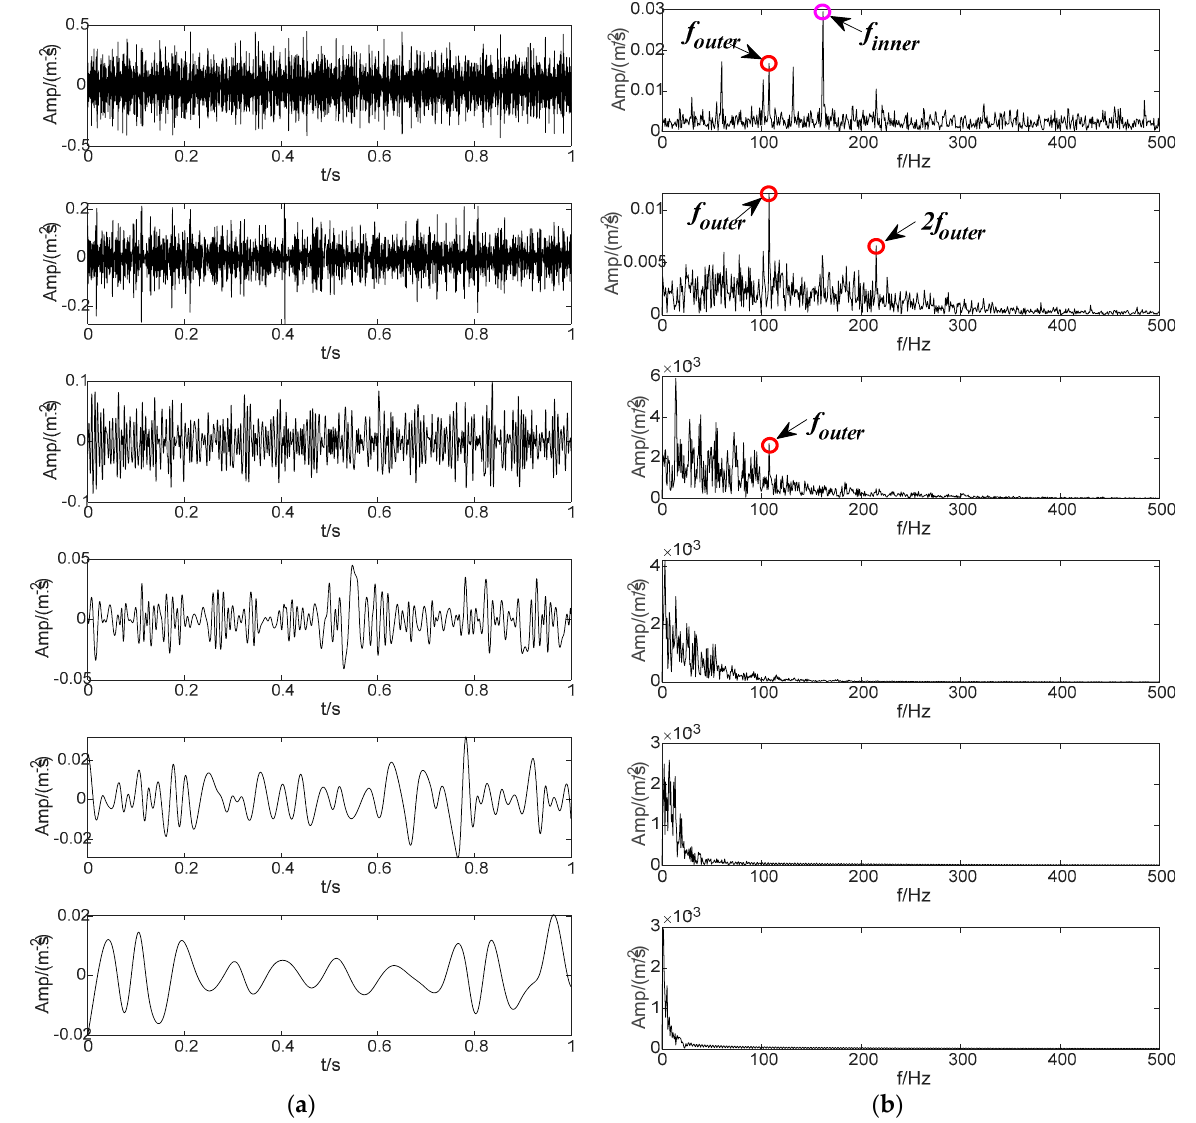
Figure 19. Decomposition result of LMD method. ( a ) The PF components obtained by LMD and ( b ) their envelope spectrums.